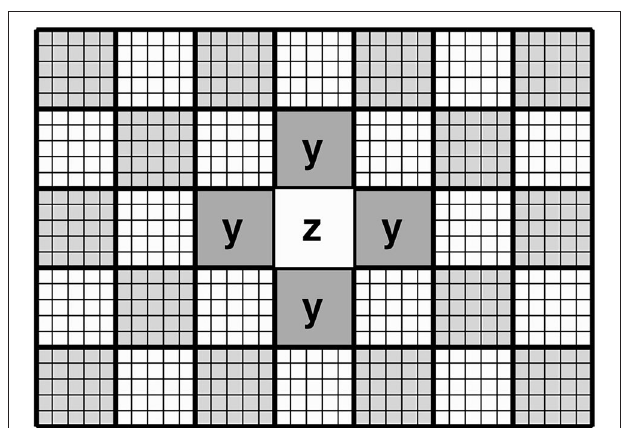
FIGURE 3 | Schematic of the “red-black” checkerboard scheme in 2D. In this illustration, updating the priors for the latent variables encoding the central (white) patch makes use of the latent variables from the four neighbouring (grey) patches. This illustrates that the latent variables in each patch are conditional on those of the neighbouring patches (Markov